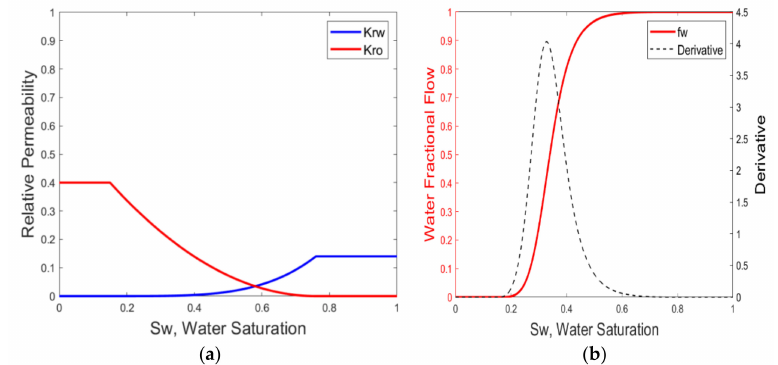
Figure 1. ( a ) Water–oil two-phase relative permeability; and ( b ) Fractional flow of water and its derivative as a function of water saturation based on parameters in Table 2.